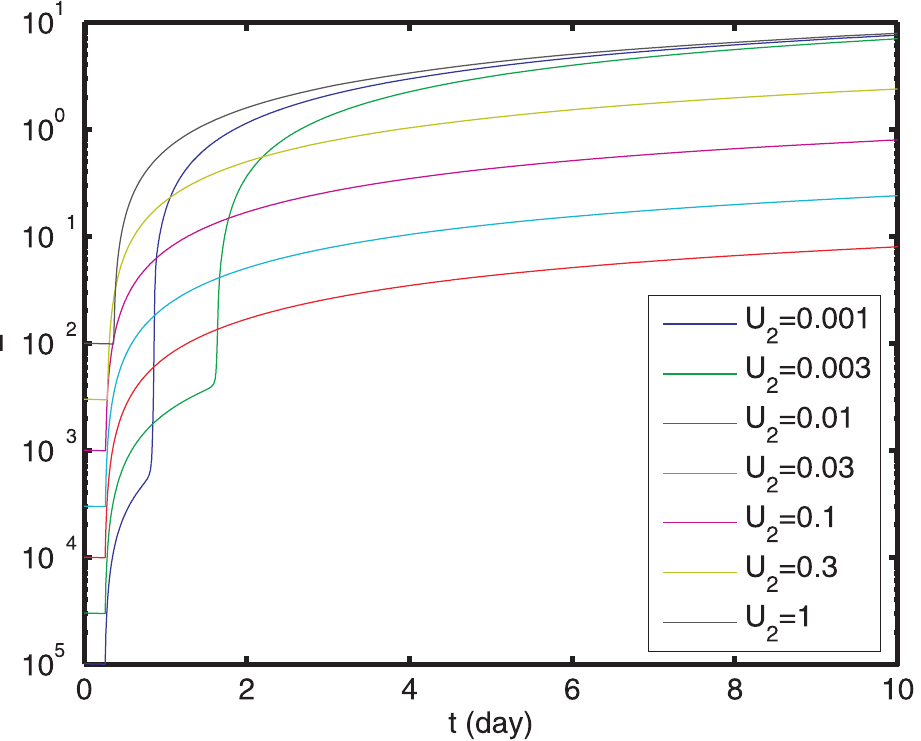
Figure 5. Trajectories of the effect of immune response, E ~ U 1 X 1 z U 2 X 2 . In each trajectory, H 0 ð Þ ~ 1 , I 0 ð Þ ~ 0 , V 0 ð Þ ~ 0 : 01,